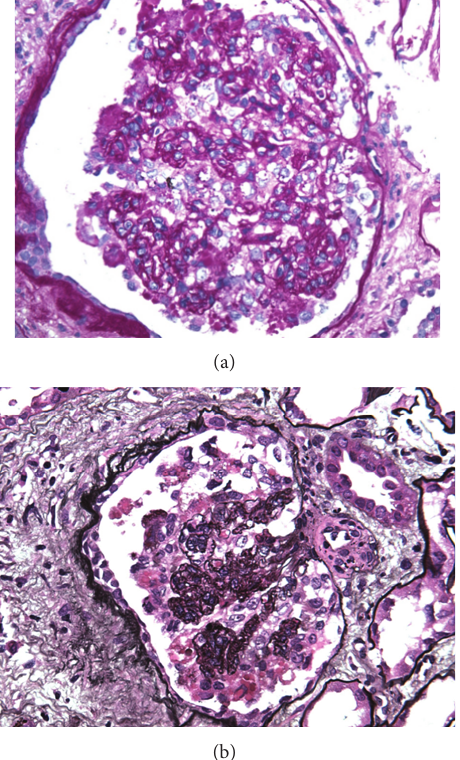
Figure 2: Light microscopy of the kidney biopsy. Glomeruli dis- played lesions of collapsing glomerulopathy which ranged from segmental to global are shown by periodic acid-Schiff (a) and methenamine silver staining